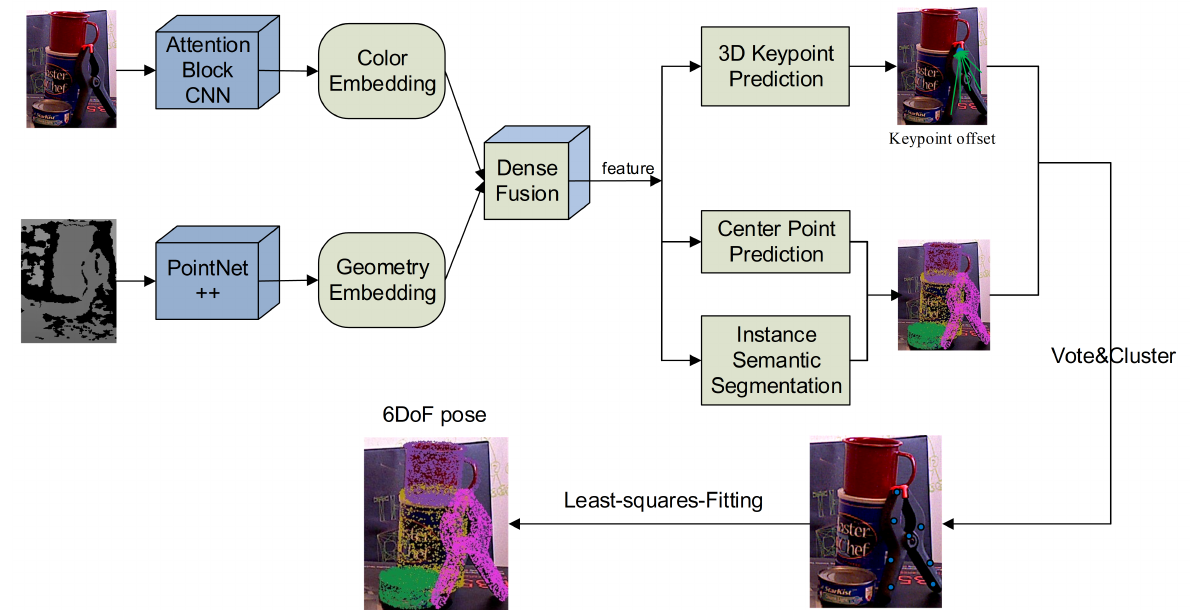
Figure 2. Overview of our algorithm. Given RGB image and point cloud, the point-wised features are extracted by the attention CNN network and PointNet++ respectively. The 3D keypoint prediction, center point prediction and instance semantic segmentation modules are trained jointly to obtain the keypoints. Finally, the 6DoF pose is estimated through the least-square